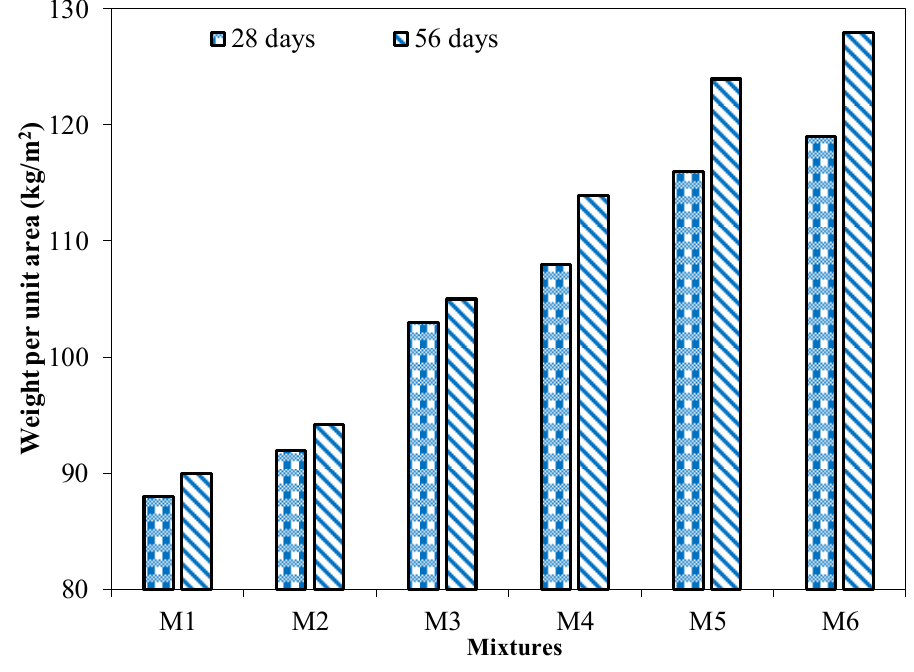
Figure 12. Weight per unit area of the brick specimen with different quantities of cement.